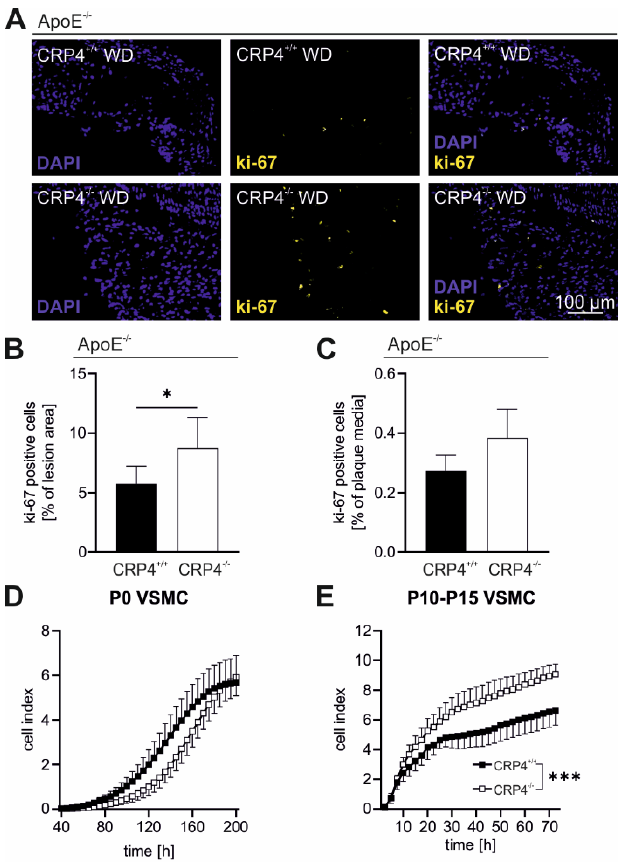
Figure 4. The ki-67 content of atherosclerotic lesions is dependent on the plaque’s CRP4 status ; ( A , B ) Ki- 67(yellow) and Hoechst (blue) stained ApoE − / − /CRP4 +/+ and dKO aortic cryosections showed a significantly higher percentage of ki-67-stained cells in the lesion area lacking CRP4, while ( C ) ki-67-positive nuclei did not differ in the media; n = 6–7 per genotype, * p < 0.05 and two-tailed Student’s t -test. ( D ) Impedance-based measurements in real-time of P0 VSMCs revealed a tendentially accelerated growth behaviour in CRP4 WT cell, while in contrast ( E ) in P10-15 cells CRP4 KO